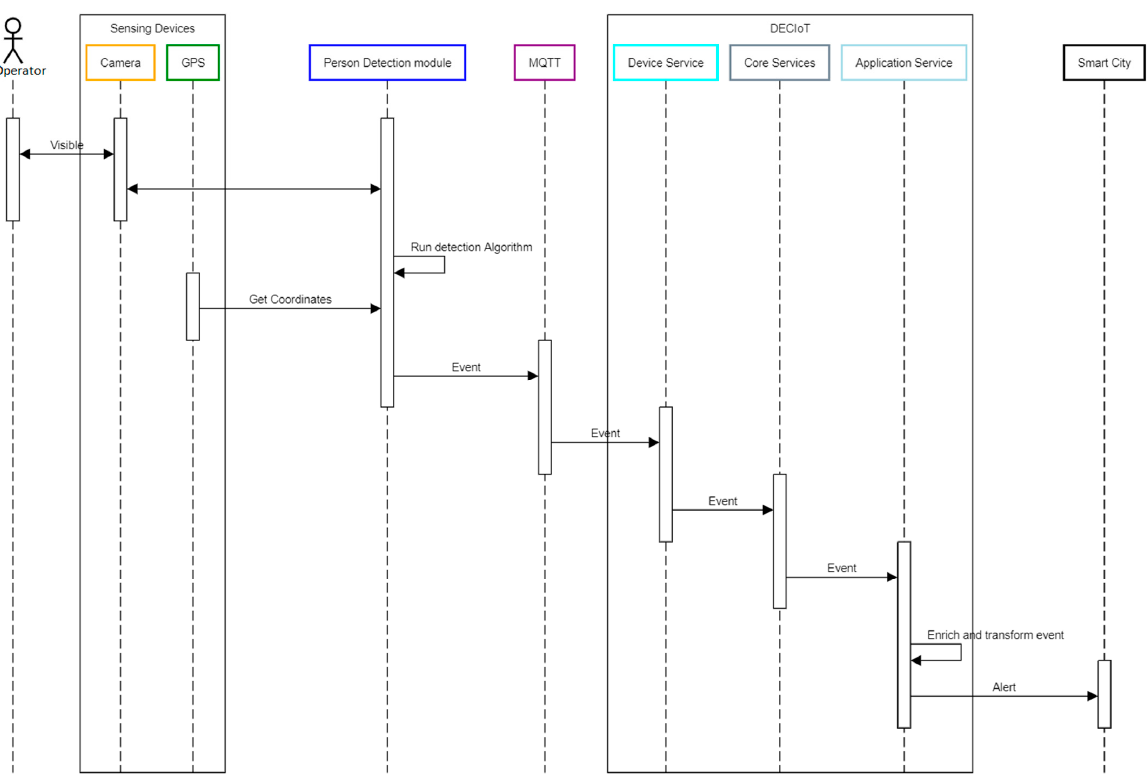
Figure 4. Sequence diagram that depicts the data flow.